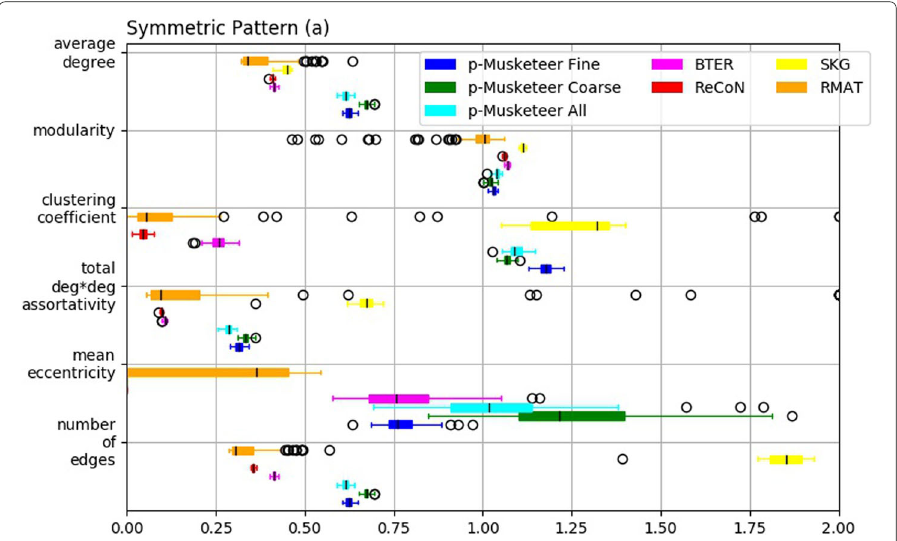
Fig. 10 Computational results on performance of planar Musketeer on symmetric pattern with 1141 nodes and 3162 edges for clustering coefficient, number of edges, mean eccentricity, total degree *degree assortativity, modularity and average